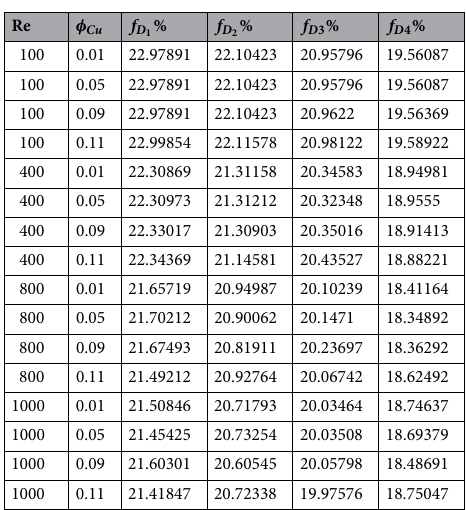
% = The percentage 2